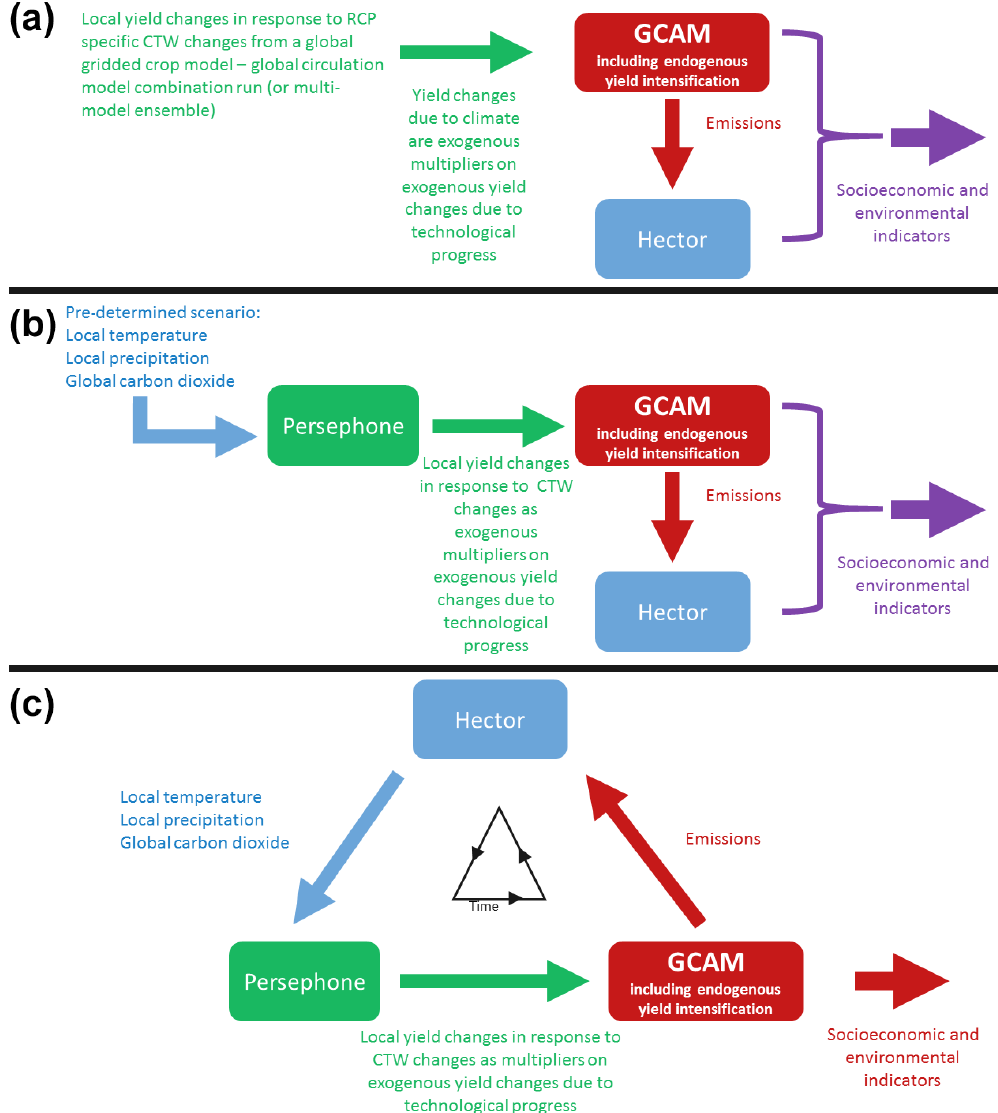
Figure 1. The current method for incorporating agricultural impacts into GCAM and two experimental designs for using Persephone v1.0 with GCAM. (a) The current method for incorporating yield changes from a global gridded crop model into GCAM. (b) A partially coupled feed-forward study incorporating yield changes from a predetermined climate scenario into GCAM. (c) A fully coupled feedback loop that iteratively updates agricultural yield